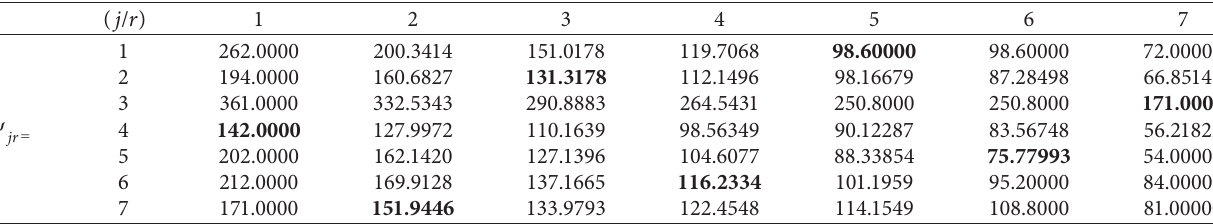
jr for Example 1.